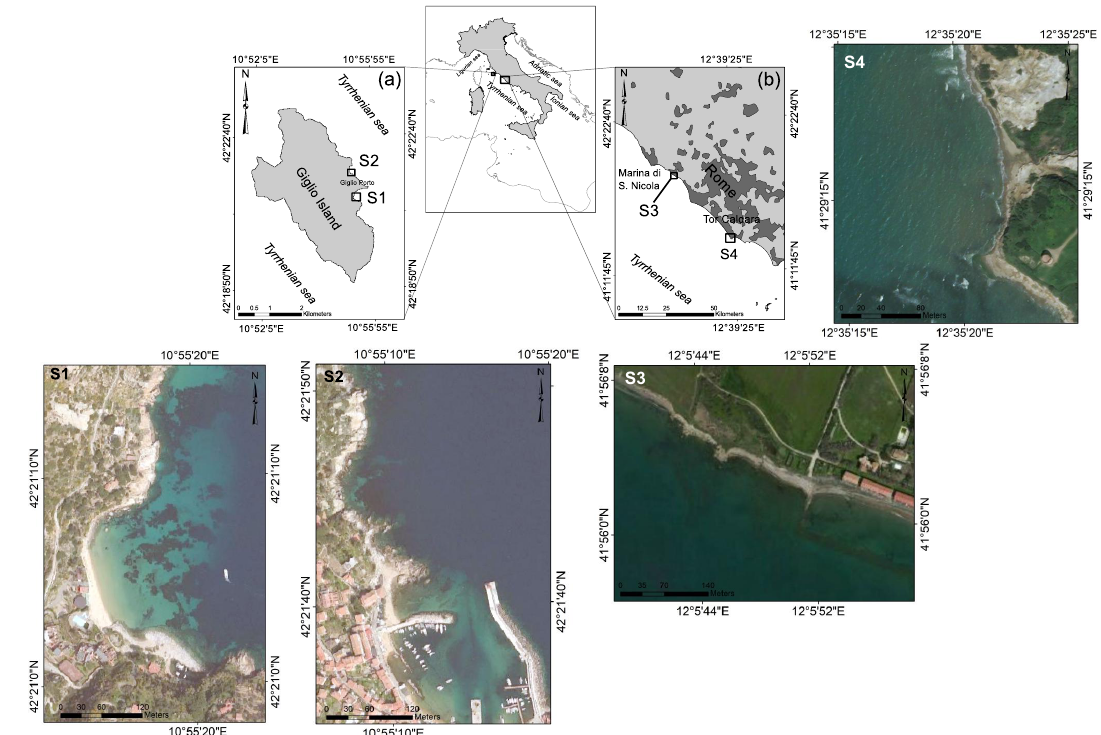
Figure 1. Location of the four surveyed areas where sensitive coastal marine habitats are